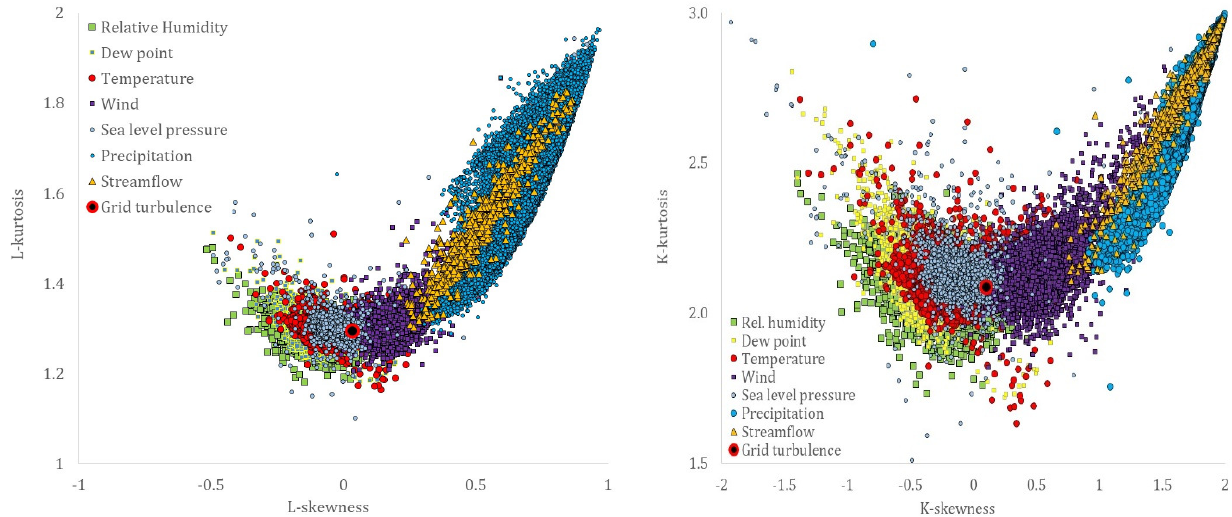
Figure 9. L-skewness vs. L-kurtosis, and K-skewness vs. K-kurtosis estimated through the hyper-central K-moments, for the key hydrological-cycle and the grid-turbulence processes.